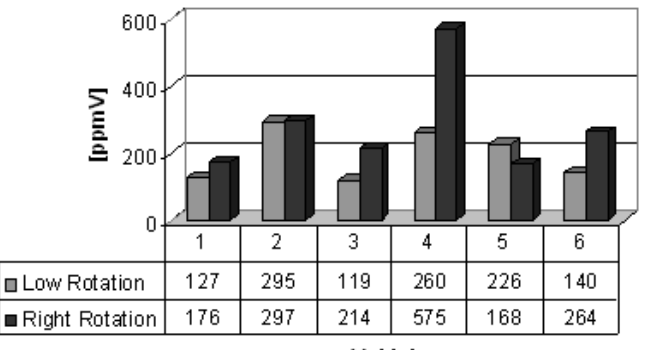
Figure 9. Nitrogen oxides concentrations [ppmV].